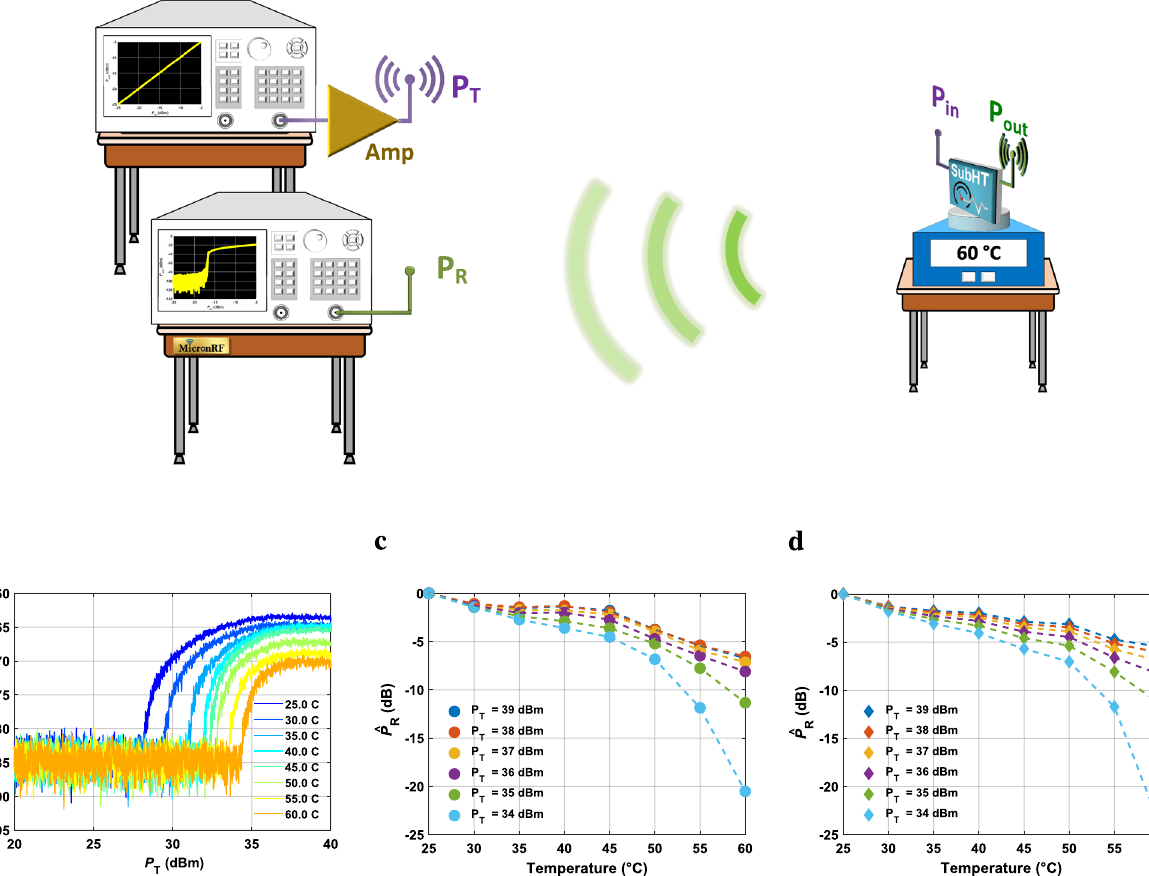
Figure 6. Wireless characterization of the built SubHT used as a WSN. ( a ) Overview of the wireless set-up used to characterize the SubHT as a WSN, sensing the local temperature at 4 meters away from two network analyzers placed in the RF test and characterization facility of our group (the MicronRF Laboratory) and together emulating a complementary interrogating node. ( b ) Measured P R versus P T trends extracted for the ˆ P R versus T trends extracted from the wireless explored temperatures. ( c,d ) Measured ( c ) and simulated ( d ) characterization of the built